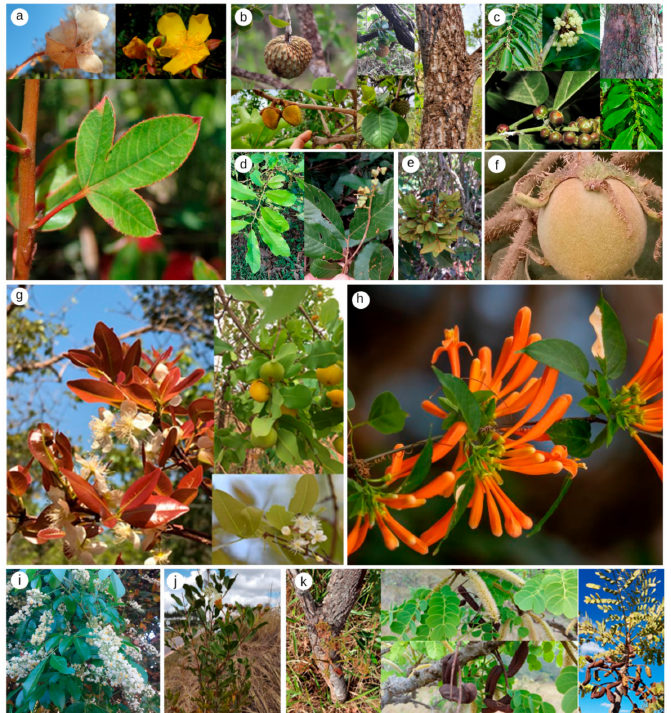
Figure 3. Most representative Cerrado species with toxic activity on different organisms according to this literature survey. ( a ) Cochlospermum regium (Mart. ex Schrank) Pilg. (“algod ã ozinho-do-campo”); ( b ) Annona crassiflora Mart (“araticum”); ( c ) Cupania cinerea Poepp. and Endl; ( d ) Casearia sylvestris Sw. var. sylvestris ( “guaçatonga”); ( e ) Connarus suberosus Planch (“bico de papagaio”); ( f ) Solanum lycocarpum A.St.-Hil. (“lobeira”); ( g ) Eugenia dysenterica (Mart.) DC (“cagaita”); ( h ) Pyrostegia venusta (Ker Gawl.) Miers (“cip ó -de-s ã o-jo ã o”); ( i ) Serjania lethalis A.St.-Hil. (“cip ó -timb ó ”); ( j ) Lafoensia pacari A.St.-Hil. (“pacari”); and ( k ) Stryphnodendron adstringens (Mart.) Coville (“barbatim ã o”). All photographs were obtained from the Herb á rio da Universidade Estadual de Goi á s (HUEG) and are available at https://www.gbif.org/pt/dataset/bbb1f181-3221-4a10-ad52-14f1da0dca26 (accessed on 23 October